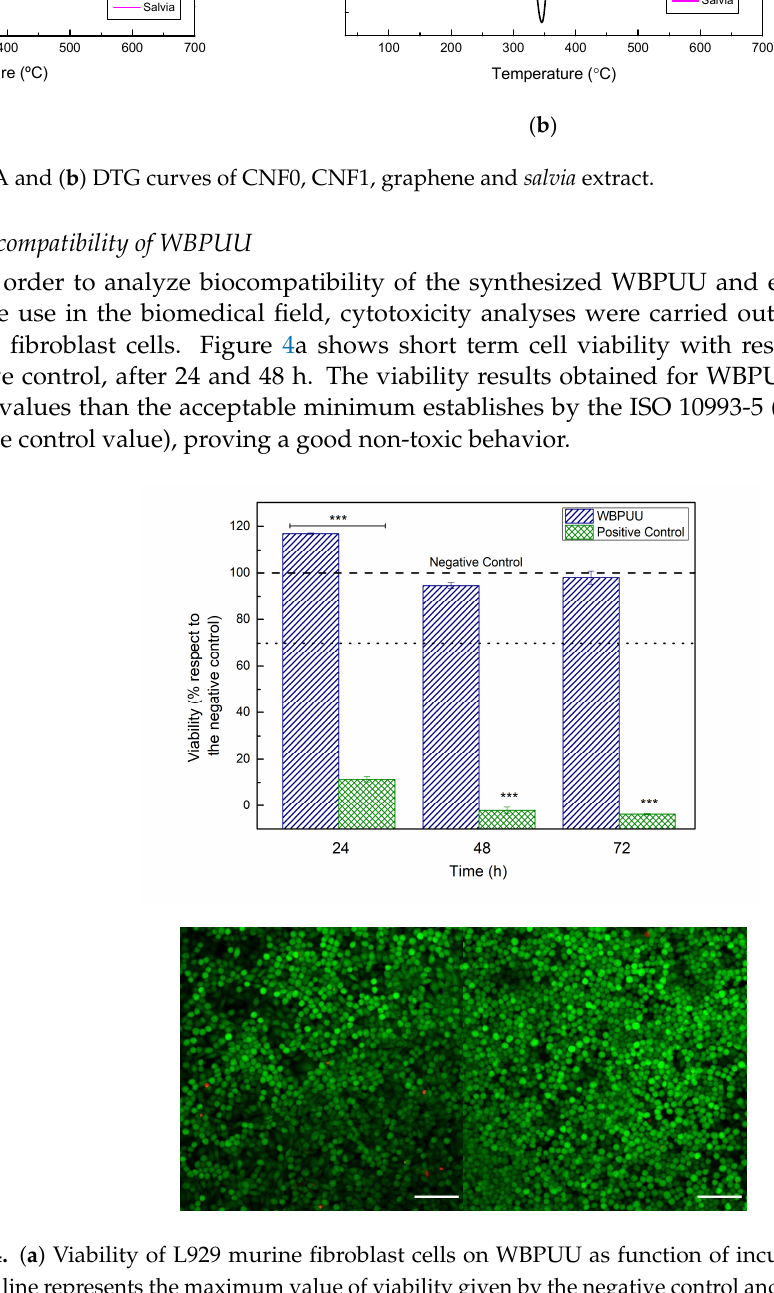
Figure 4. ( a ) Viability of L929 murine fibroblast cells on WBPUU as function of incubation time. *Dotted line represents the maximum value of viability given by the negative control and dashed line represents the limit of acceptance stablished by ISO 10993-5:2009 (70% of the value of the negative control); * p < 0.05. ( b ) Adhesion and viability (Live/Dead assay) of L929 cells on WBPUU surface after 3 ( left ) and 7 ( right ) days. Scale bar on confocal microscopy images represents 100 μm.